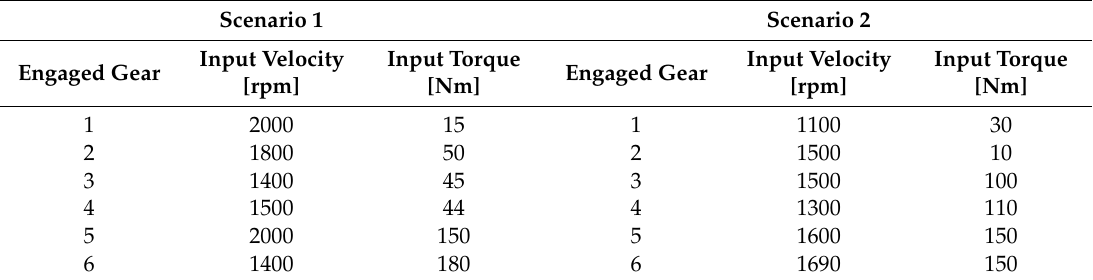
Figure 9. Real Driving Emissions (RDE) driving cycle. Table 7. Scenarios of operating conditions examined.